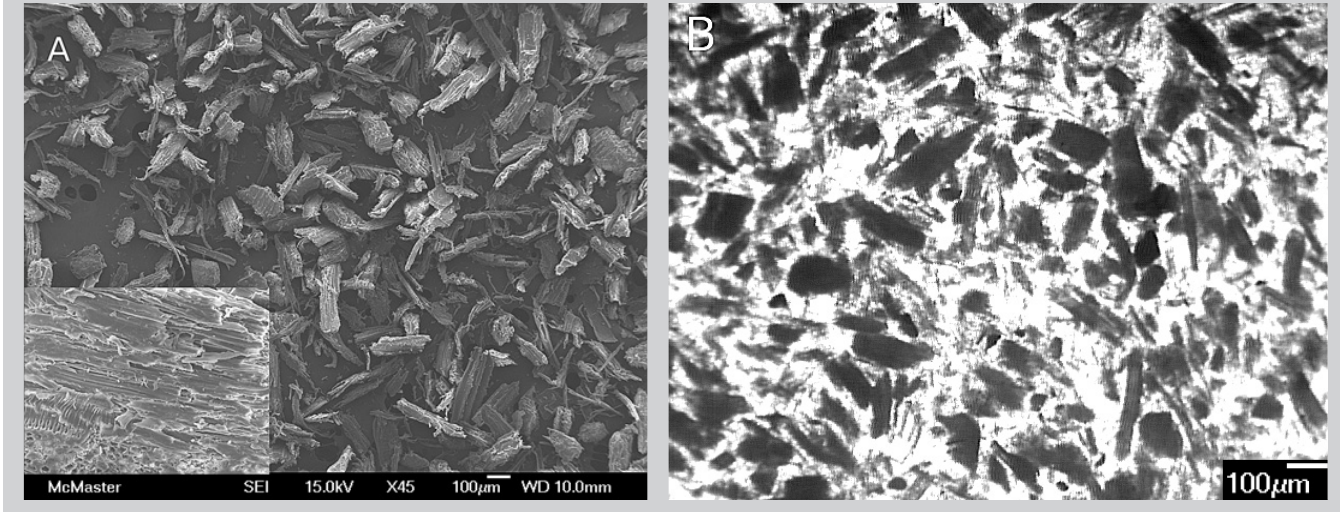
Figure 1: Scanning electron micro- graphs of: a) raw wood flour, insert at